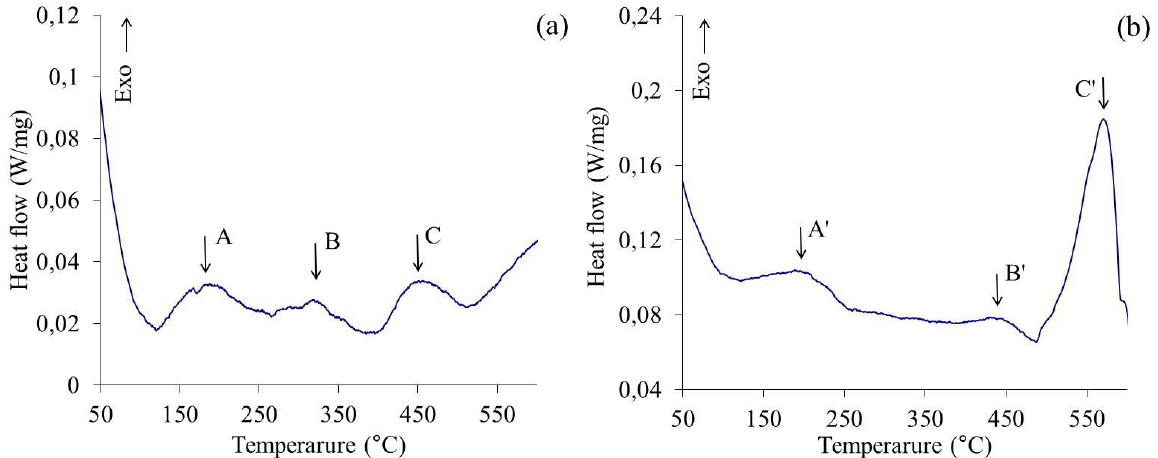
Figure 2. DSC curves of composite powders with additions of ( a ) 2% stearic acid and ( b ) 5% Cu.